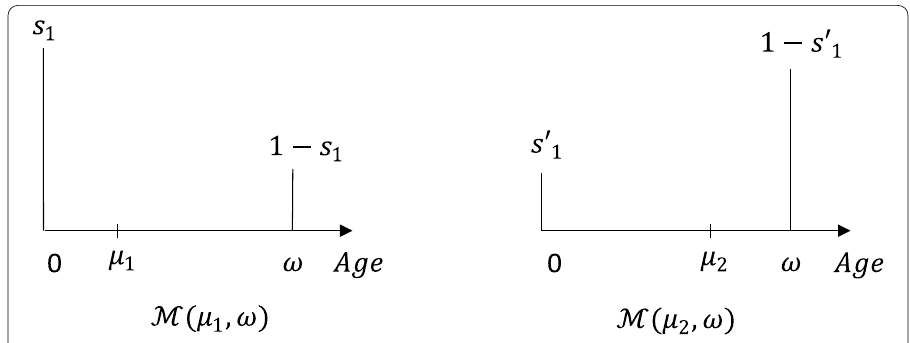
Fig. 9 Two generic examples of inequality-maximizing distributions for different mean values ( µ 1 and µ 2 ). (Source: Authors’